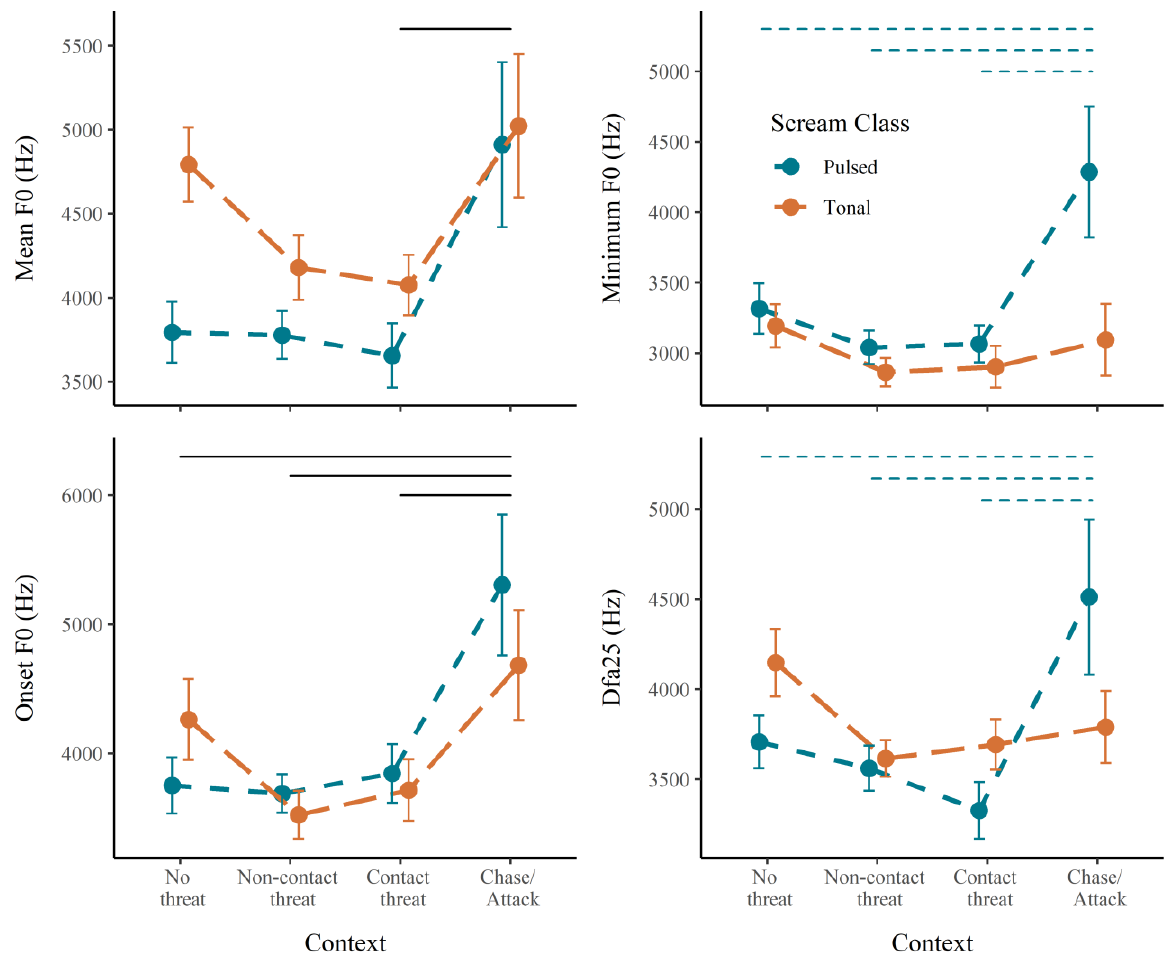
Figure 2 . Acoustic variation within scream classes, and relationship to context, with lowest arousal on the left and highest arousal on the right. Horizontal lines denote significant pairwise differences for all screams regardless of class (solid black line) or for pulsed screams only (dotted